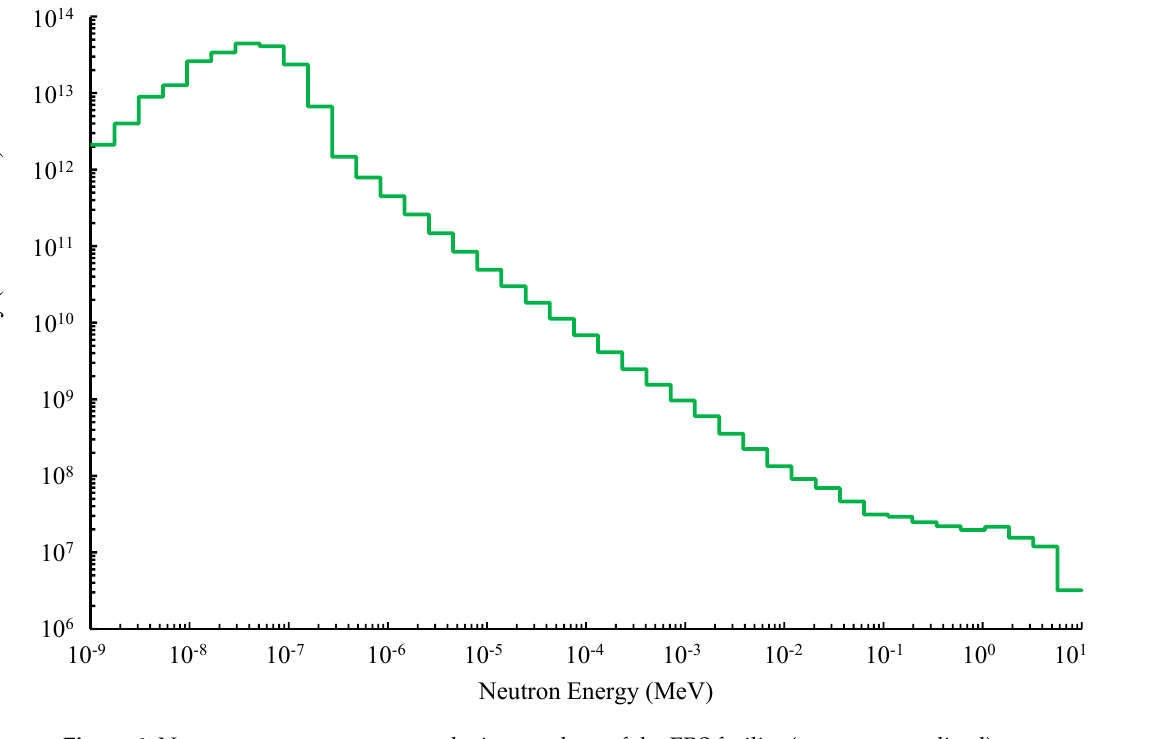
Figure 6. Neutron energy spectrum at the image plane of the ERS facility (energy-normalized). Table 9. Tabulated neutron flux ( n /cm 2 /s) values from the hybrid spectrum.